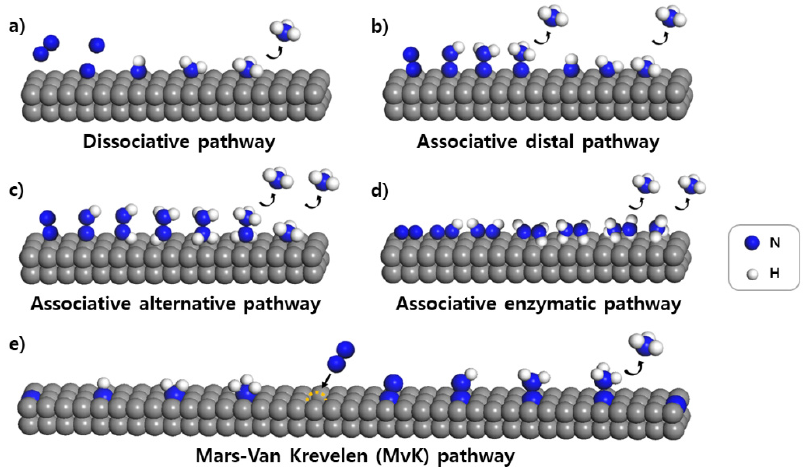
Figure 2. The mechanisms of NRR. ( a ) Dissociative pathway; ( b ) associative distal pathway; ( c ) as- sociative alternative pathway; ( d ) associative enzymatic pathway; and ( e ) Mars–Van Krevelen (MvK) pathway.